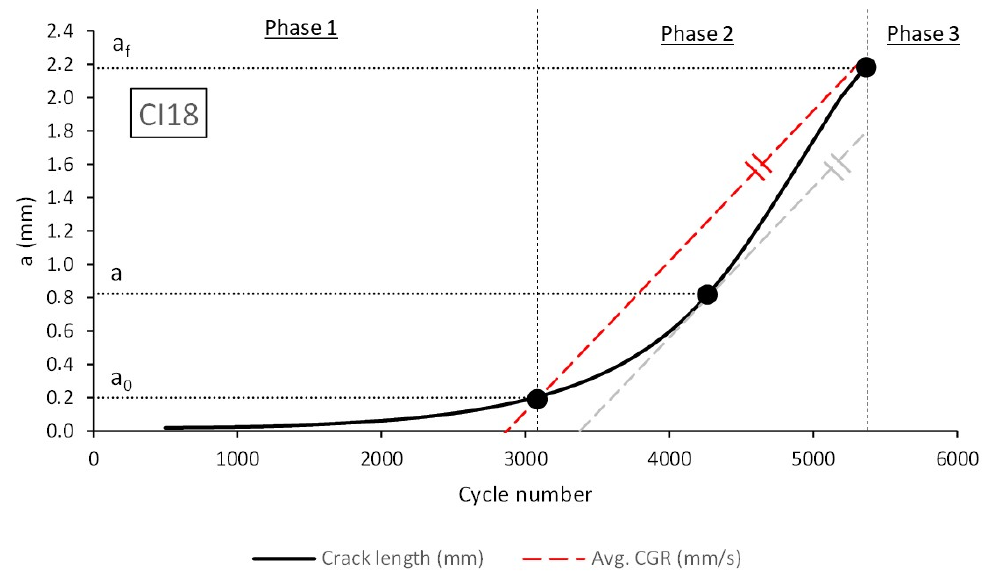
Figure 7. Estimation of crack size evolution derived from the DCPD signal and the crack geometrical model considered in this work.